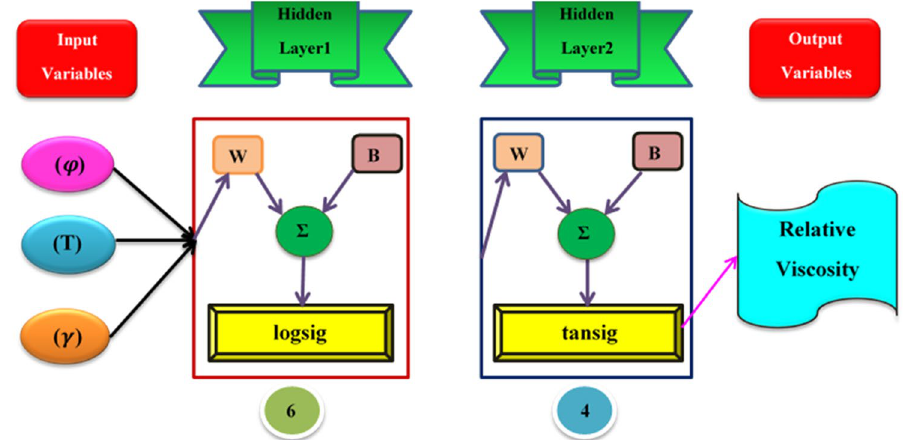
Figure 1. The best ANN.